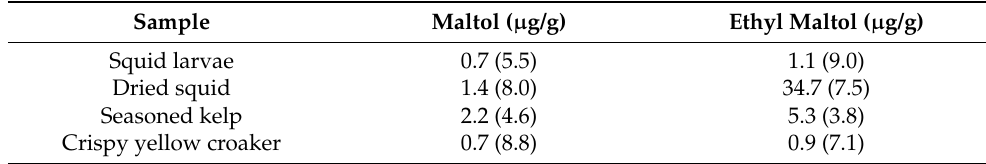
Table 4. Determination of maltol and ethyl maltol in seafood a . Sample Maltol ( µ